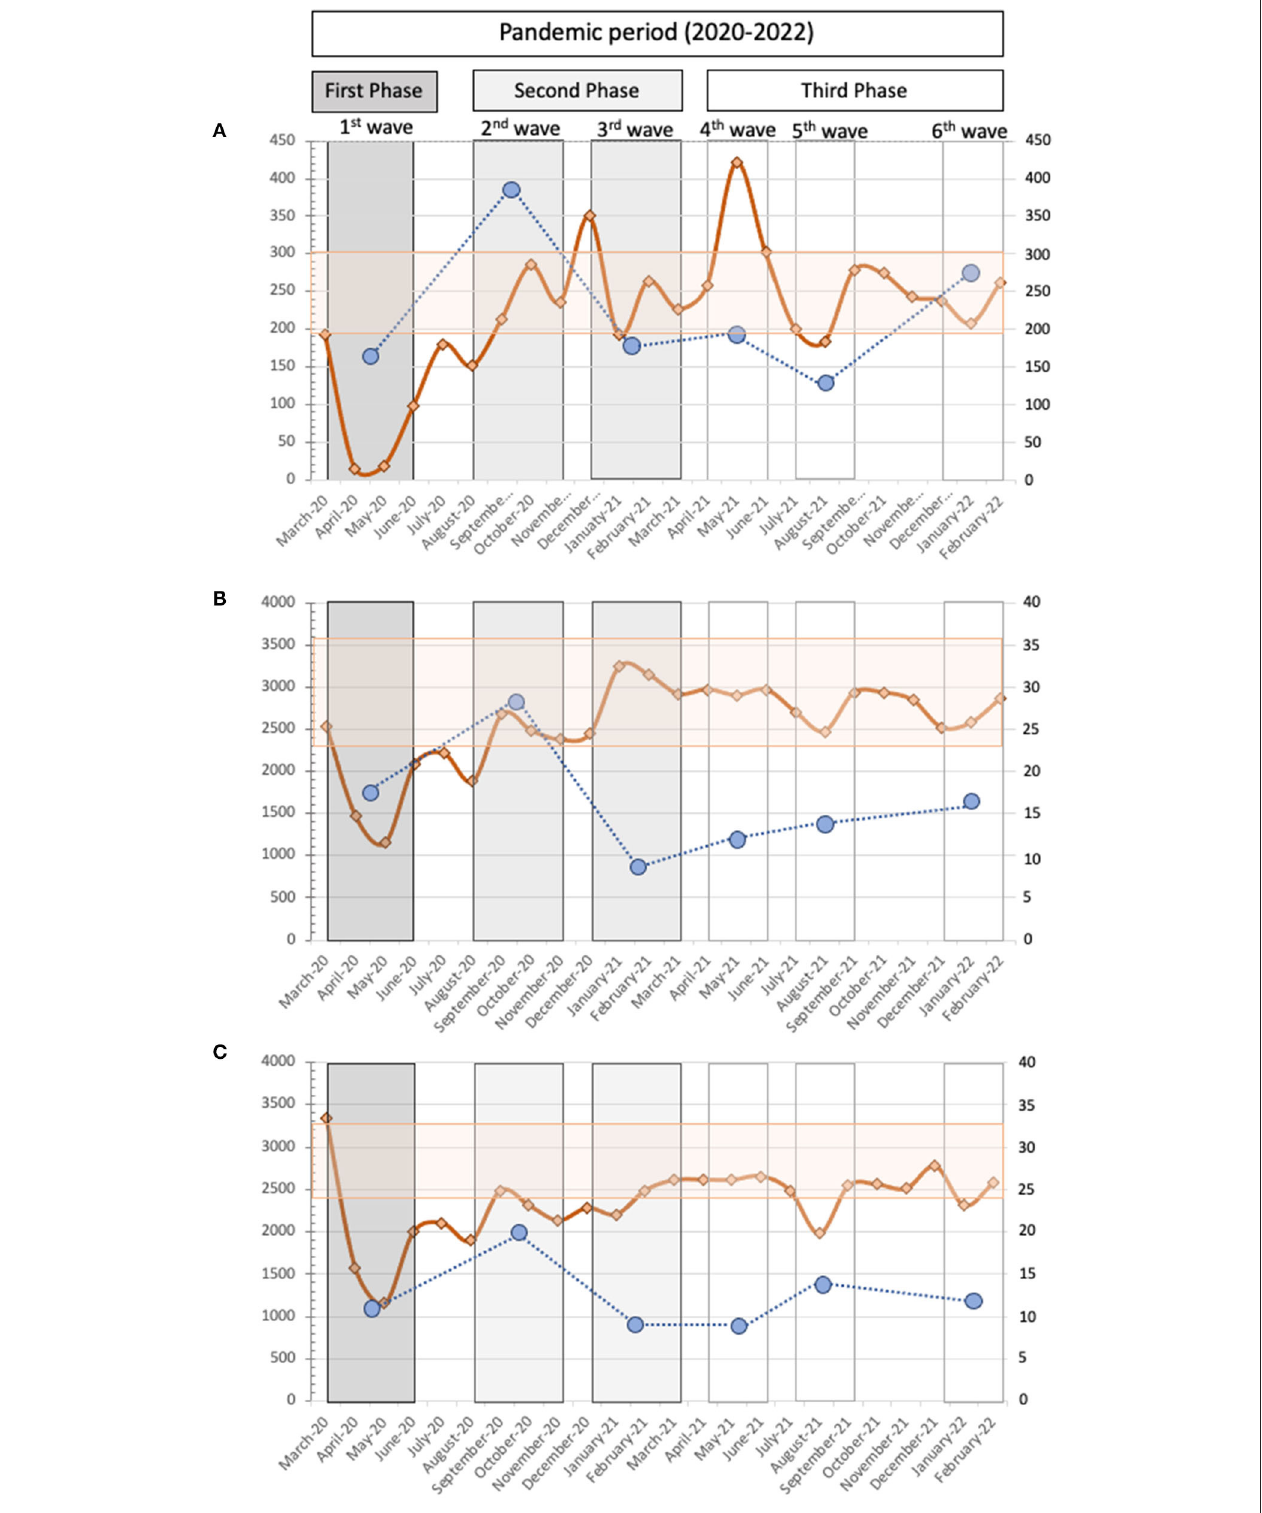
FIGURE 2 | The monthly distributions of samples analyzed along the pandemic period for (A) HPV, (B) HCV, and (C) HIV are represented by orange solid lines. The upper/lower limit of samples/months obtained in pre-pandemic period are represented as light orange horizontal stick. The right y-axis corresponds to number of samples analyzed. The left y-axis corresponds to new diagnoses. Blue circles correspond to hrHPV infected patients (A) , viremic HCV patients (B) , or positive serological status against HIV (C) , in no previously known patients, in each pandemic wave (I–VI).